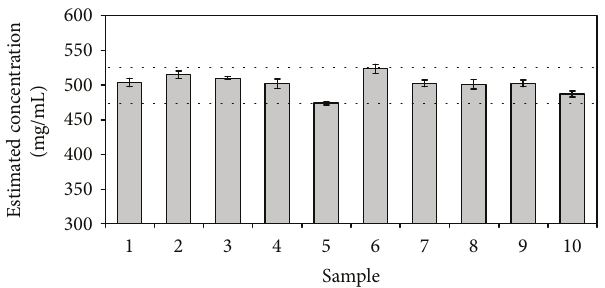
Figure 5: Estimated concentration values using the PCR model applied to the Raman spectra of the commercial solutions containing dipyrone 500mg/mL. The error bars are based on the triplicate spectra. The ± 5% precision limit of ANVISA is